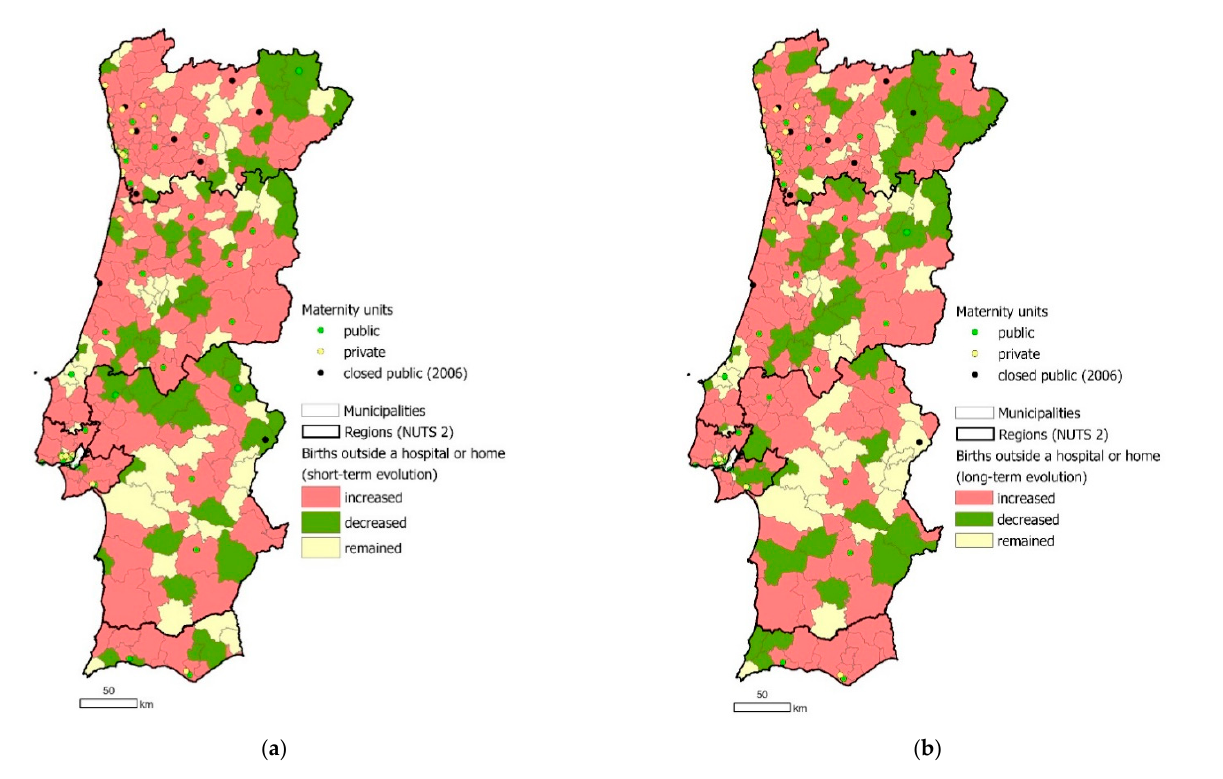
Figure 4. Impact of 2006 policy change: change in roadside deliveries in Portugal in the short term ( a ) and long term ( b ) compared to the closure of maternity units. Source: based on data retrieved from the National Institute of Statistics portal [26], the NHS portal [24] and the Birth Advisor portal [25].